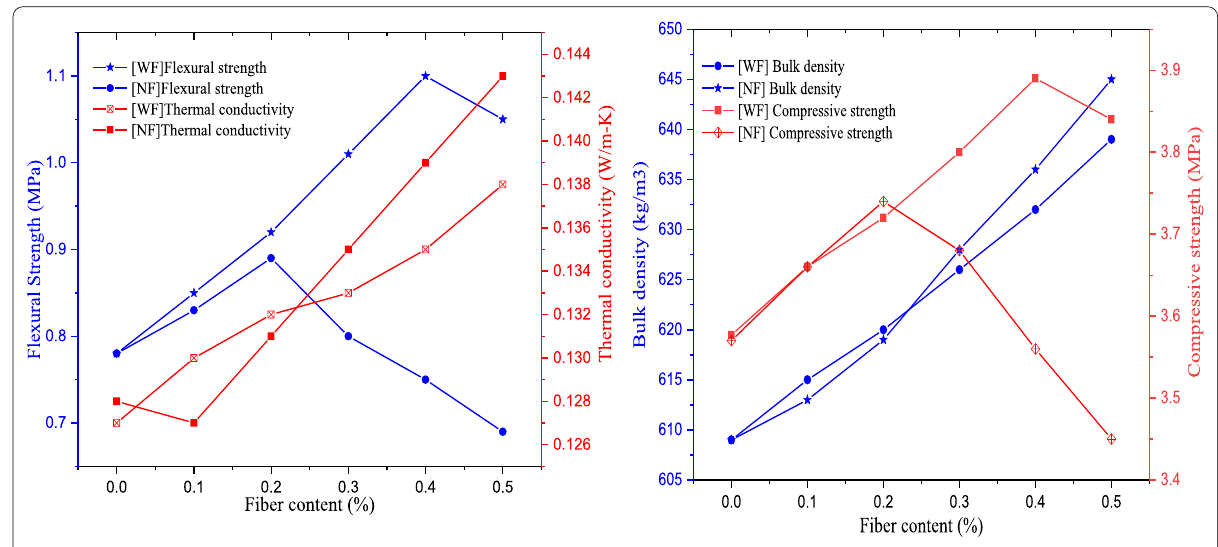
Fig. 5 Influence of fiber addition on the properties of AAC (Pehlivanlı et al.,